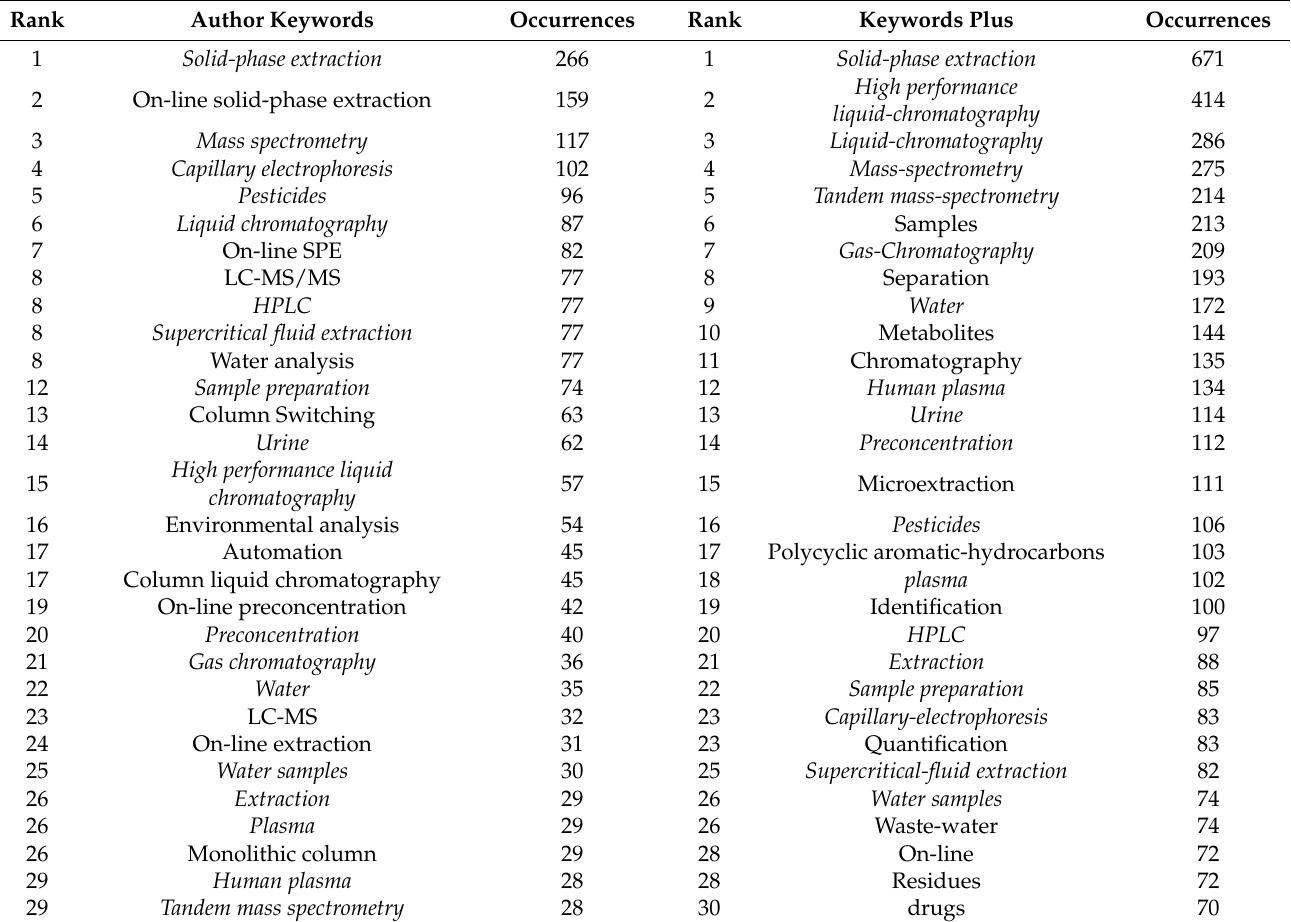
Table 3. Top 30 most frequent keywords (author keywords and keywords